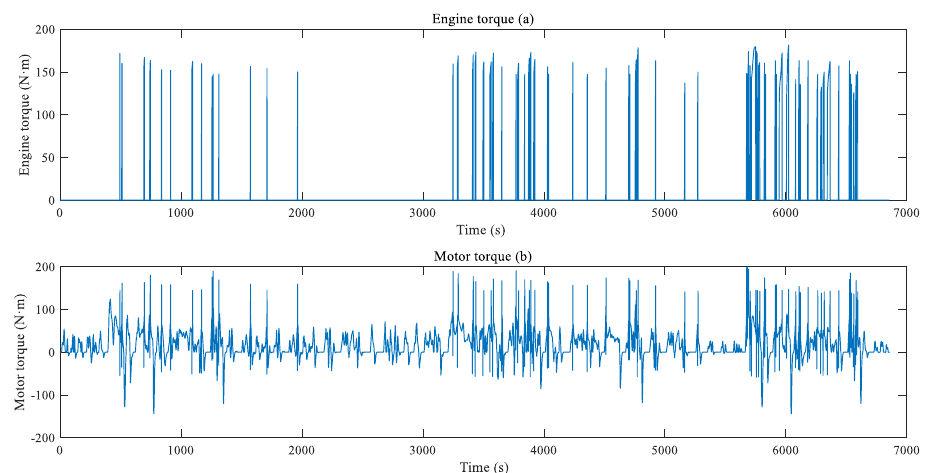
Figure 15. The A − ECMS torque distribution based on cycle prediction. ( a ) energy torque; Figure 15. The A−ECMS torque distribution based on cycle prediction. ( a ) energy torque; ( b ) mo- ( b ) motor torque. tor torque.